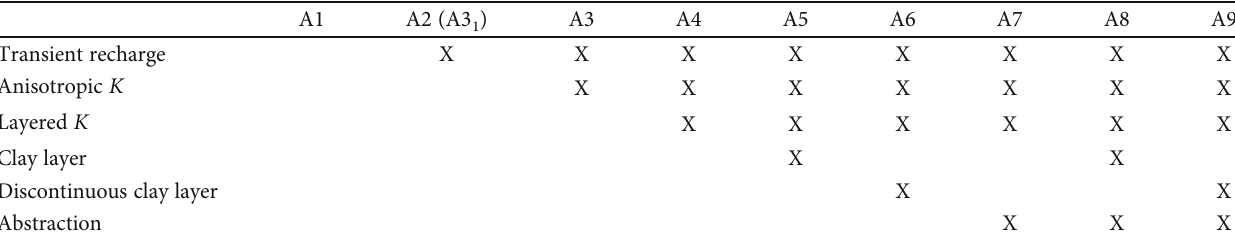
Table 1: Overview of the model